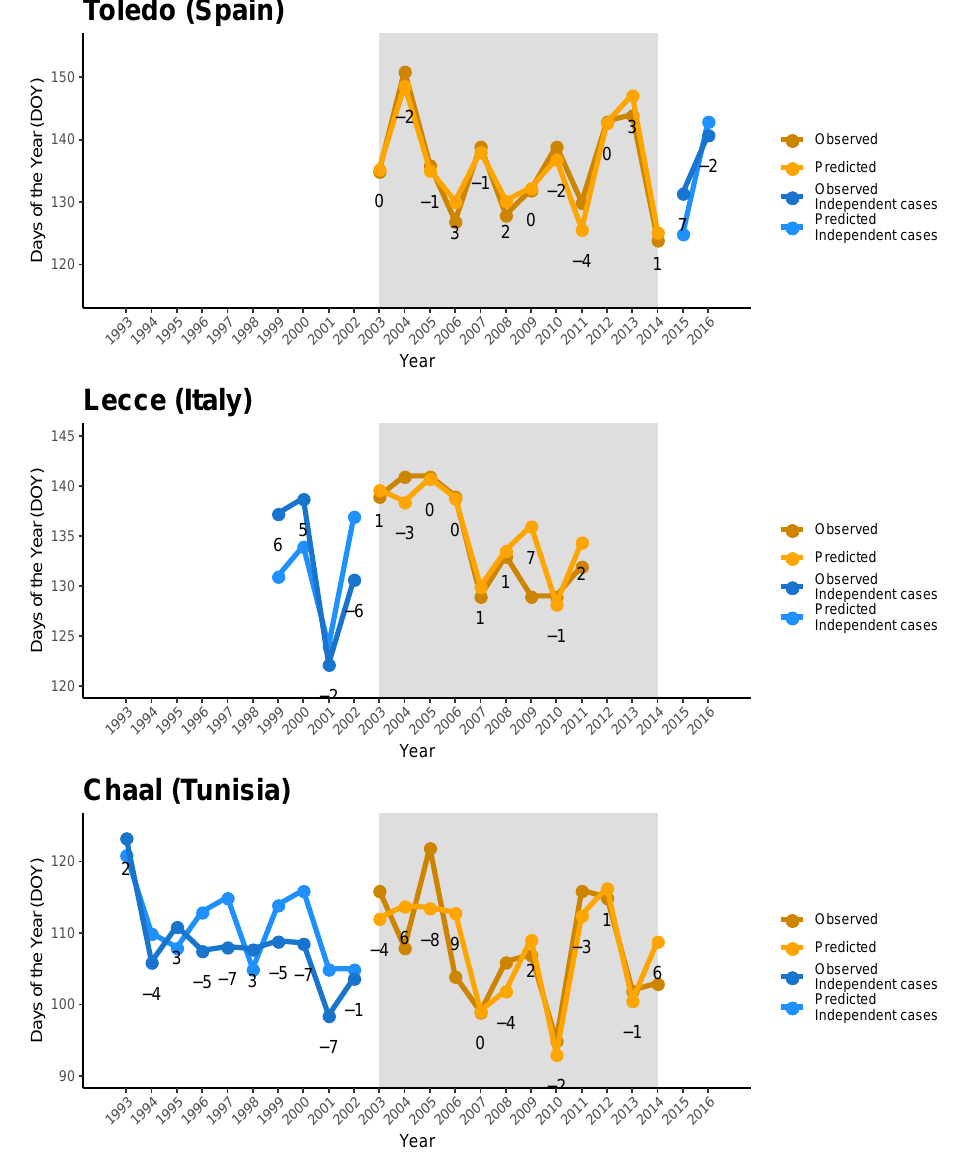
Figure 7. Estimated vs. observed start date of flowering based on the chilling and heat